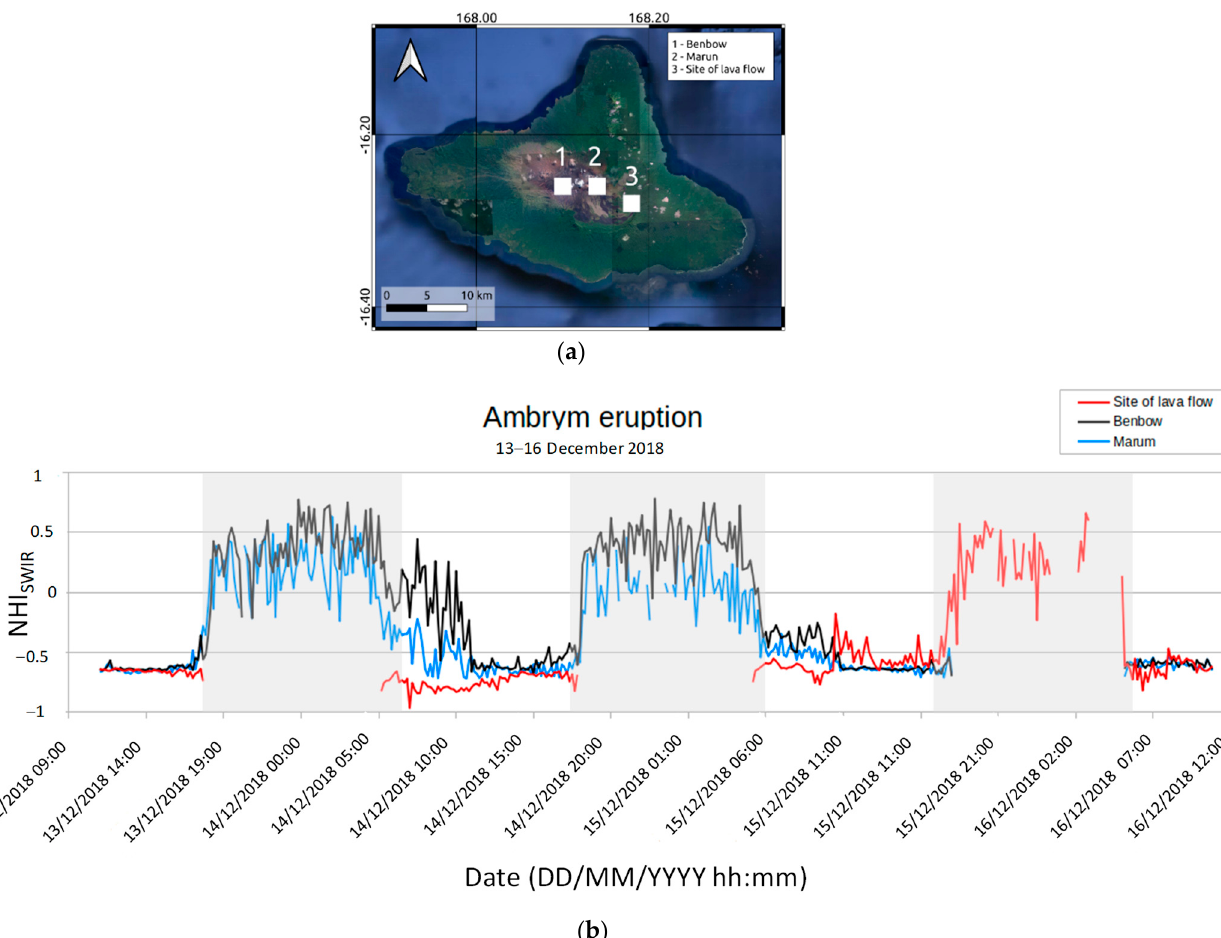
Figure 2. ( a ) Pixel boxes centred over Benbow (area #1), Marum (area #2) and SE flank of the Marum crater (area #3); ( b ) Time series of the NHI SWIR index retrieved over the period 13 December 2018 at 09:00 LT − 16 December 2018 at 11:00 LT, night-time intervals (17:00 − 06:00 LT) are marked in light grey. Note that the index was not calculated in the presence of low SWIR radiance values recorded at night-time for the reasons discussed in the text (see red curve; area #3).